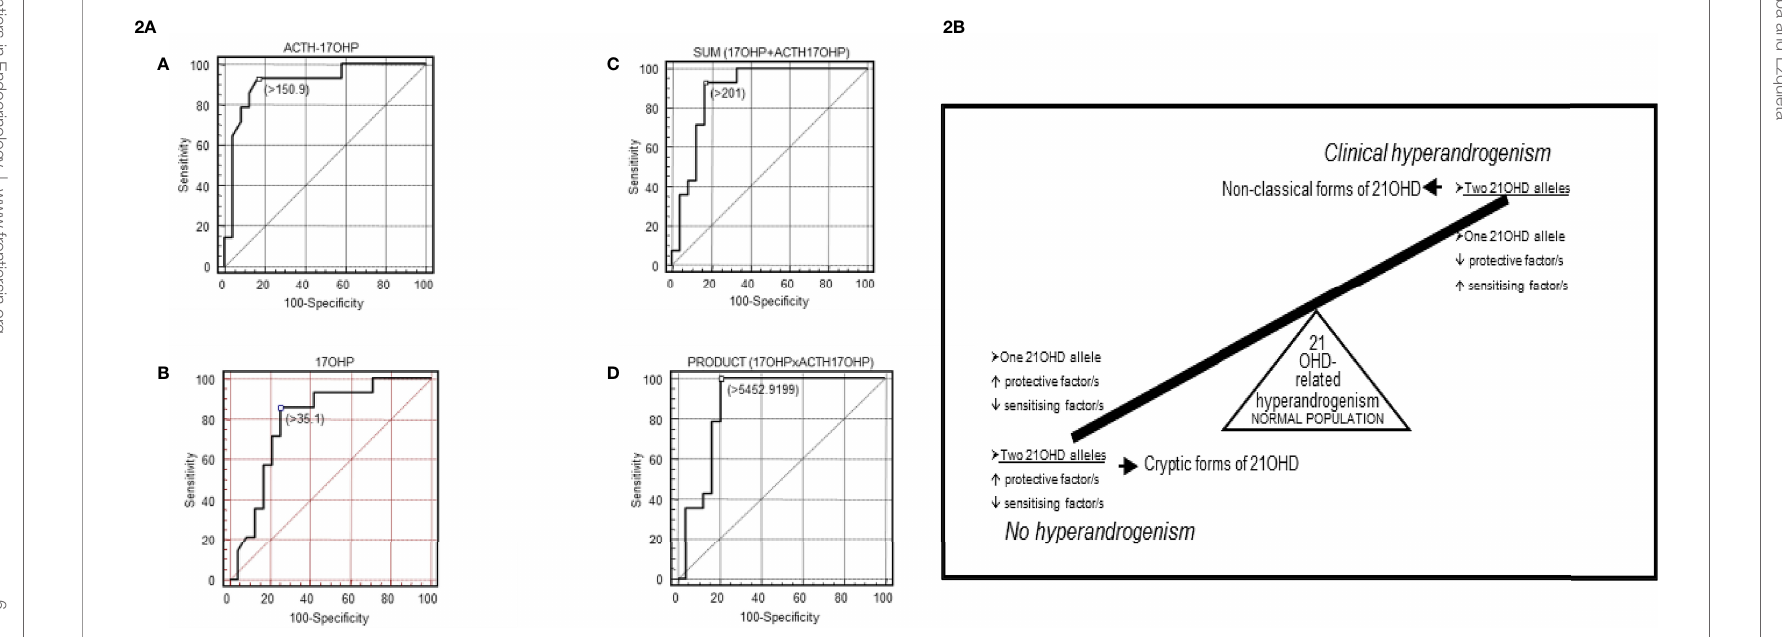
FIGURE 2 | (2A) [Taken from Ezquieta et al., (56)]: Receiver operating characteristic (ROC) curves analyses in fully genotyped children affected with NCF of 21-OHD (mild/mild vs severe/mild genotype) for: (A) adrenocorticotropic hormone (ACTH)-stimulated 17-OHP, (B) basal 17-OHP, or (C, D) the combination of both parameters [ (C) : sum; (D) : product]. Areas under the curves (SE): ACTH-stimulated 17-OHP, 0.908 (0.057); basal 17-OHP, 0.790 (0.081); sum 0.866 (0.068); product 0.884 (0.064). Cut-off values, nmol/L (A – C) and nmol 2 /L 2 (D) . The cut-offs for maximum predictive values are represented by small, empty squares in the Figures. (2B) [From Ezquieta et al., (91)] Diagram of a hypothetical interaction between protective and sensitizing factors modulating the clinical expressivity of 21-OHD-related hyperandrogenism. CAPN10- UCSNP44C and TNFR2-R196 are proposed in this study to be sensitizing and protective factors,